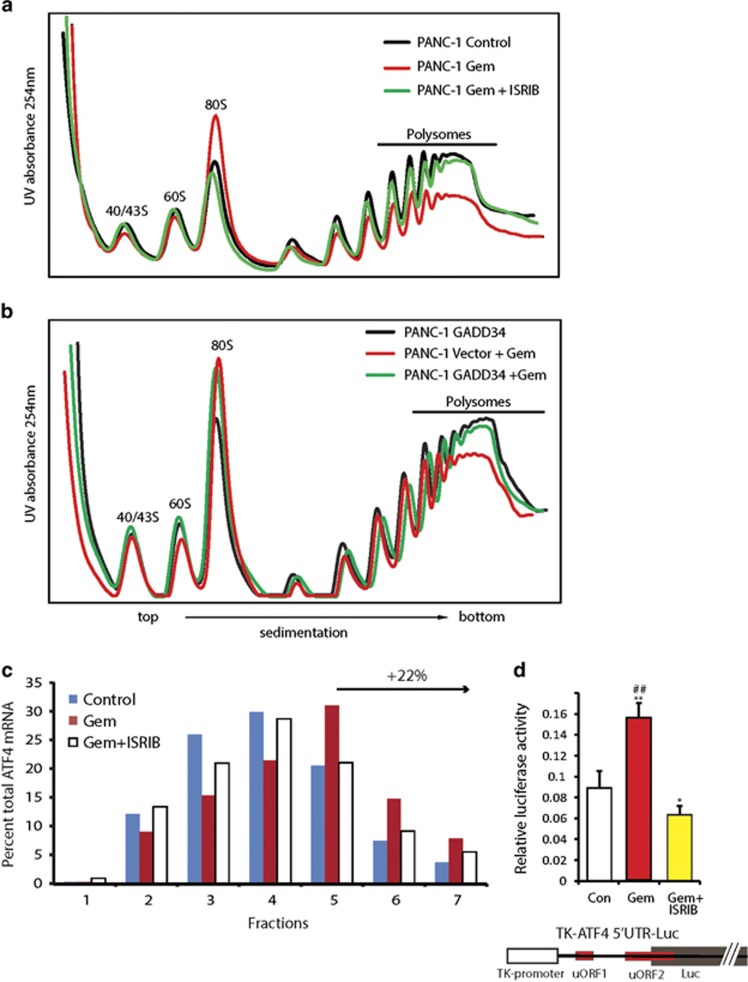
Gemcitabine causes translation repression in pancreatic cancer cells. (a) PANC-1 cells were incubated for 12 h in the absence or presence of 10 μM Gem or 0.5 μM ISRIB. Cell lysates were subjected to sucrose gradient centrifugation, and gradients were fractionated in-line with 254 nm UV absorbance measurement. Top fractions containing free ribosomal subunits are labeled as 40/43S, 60S. Mono ribosomes are labeled as 80S. Ribosomes bound to RNA fractions were labeled as polysomes. (b) PANC-1 cells were transfected with an empty vector or the GADD34 plasmid DNA, and incubated 24 h later with 10 μM Gem for 12 h. Cell lysates were analyzed for polysome profiles as in (a). (c) PANC-1 cells were incubated in the absence or presence of Gem or ISRIB+Gem and subjected to sucrose gradient centrifugation as in (a). Fractions were collected and luciferase (10 ng/ml) spiked into each fraction. RNA Isolated and ATF4 transcript levels were quantitated using qRT-PCR, and normalized to spike-in luciferase control. The percent total ATF4 transcript for each fraction is represented. Fractions 5, 6, and 7 corresponds to fractions with polysomes rich in translation. (d) PANC-1 cells were transfected with the TK-ATF4-Luc plasmid construct that with illustrated features: ATF4 5′UTR harboring uORF1 and uORF2, TK promoter and Luciferase coding region. At 24 h post transfection cells were incubated for 12 h in the absence or presence of 10 μM Gem and 0.5 μM ISRIB. Firefly luciferase units were measured and normalized to internal control Renilla luciferase activity. Data are the means ±S.D. of three experiments. *P<0.05, **P<0.005 compared with control, ##P<0.001 compared with Gem+ISRIB. Panels a and b show representative data from three independent experiments